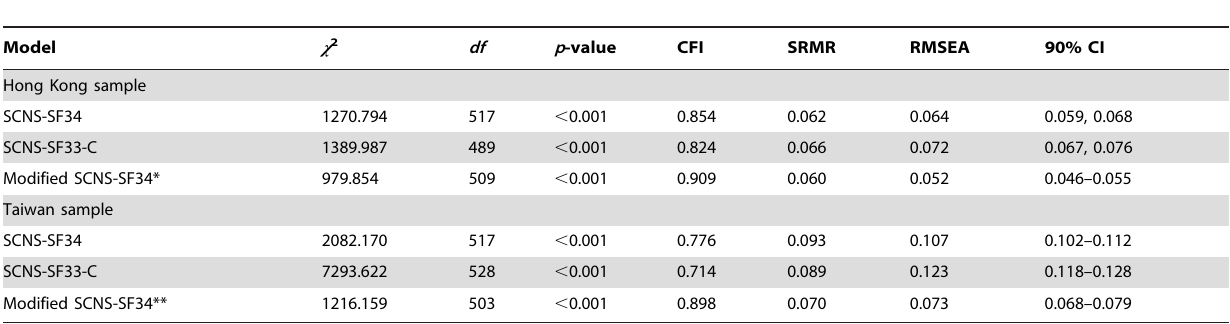
Table 2. Confirmatory Factor Analysis (CFA), goodness-of-fit indices of Supportive care needs survey (SCNS-SF).